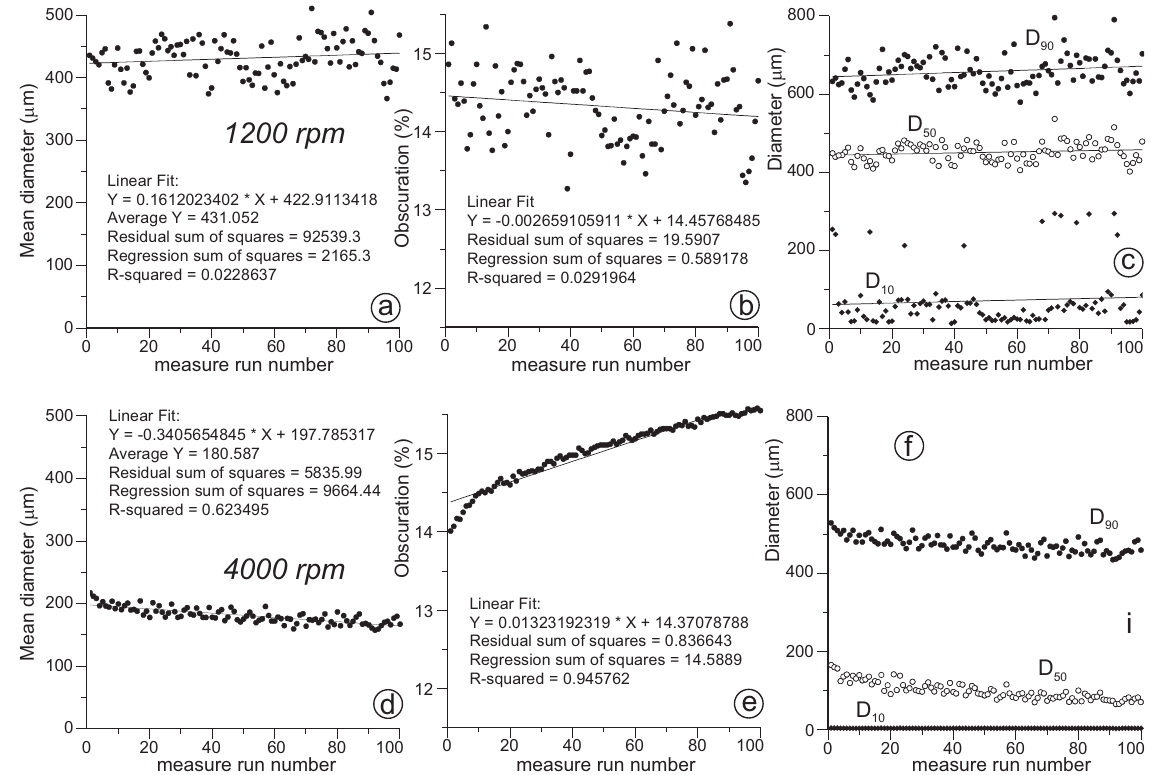
Fig. 10. Comparison between measurement precision test results performed on sample CABRE3 at the pump speed velocity corresponding to the mean diameter peak value of the pump speed test (Fig. 3a), and at the maximum pump speed, respectively. (a) Test MP1200 5 performed on sub-sample aliquot CABRE3e by the Hydro 2000 MU dispersion unit; mean diameter value evolution with increasing the number of measurement runs. Data statistics are provided. (b) Laser obscuration value progression during the same test. Data statistics are provided. (c) Progression of D 10 , D 50 , and D 90 percentiles during the same test. (d) Test MP4000 5 performed on sub-sample aliquot CABRE3f by the Hydro 2000 MU dispersion unit; mean diameter value evolution with increasing the number of measurement runs. Data statistics are provided. (e) Laser obscuration value progression during the same test. Data statistics are provided. (f) Progression of D 10 , D 50 , and D 90 percentiles during the same test. Note the very large difference between the average mean diameter obtained from the first (431.052µm) and the second test (180.587µm), respectively. Both them are affected by strong recirculation-related mechanical